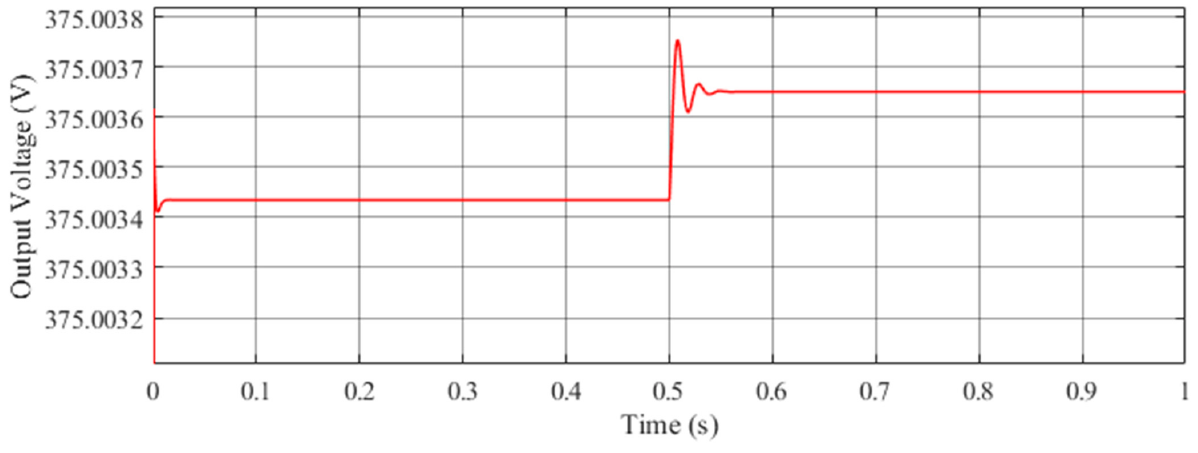
Figure 12. Output voltage for inductive load in the d - q frame.